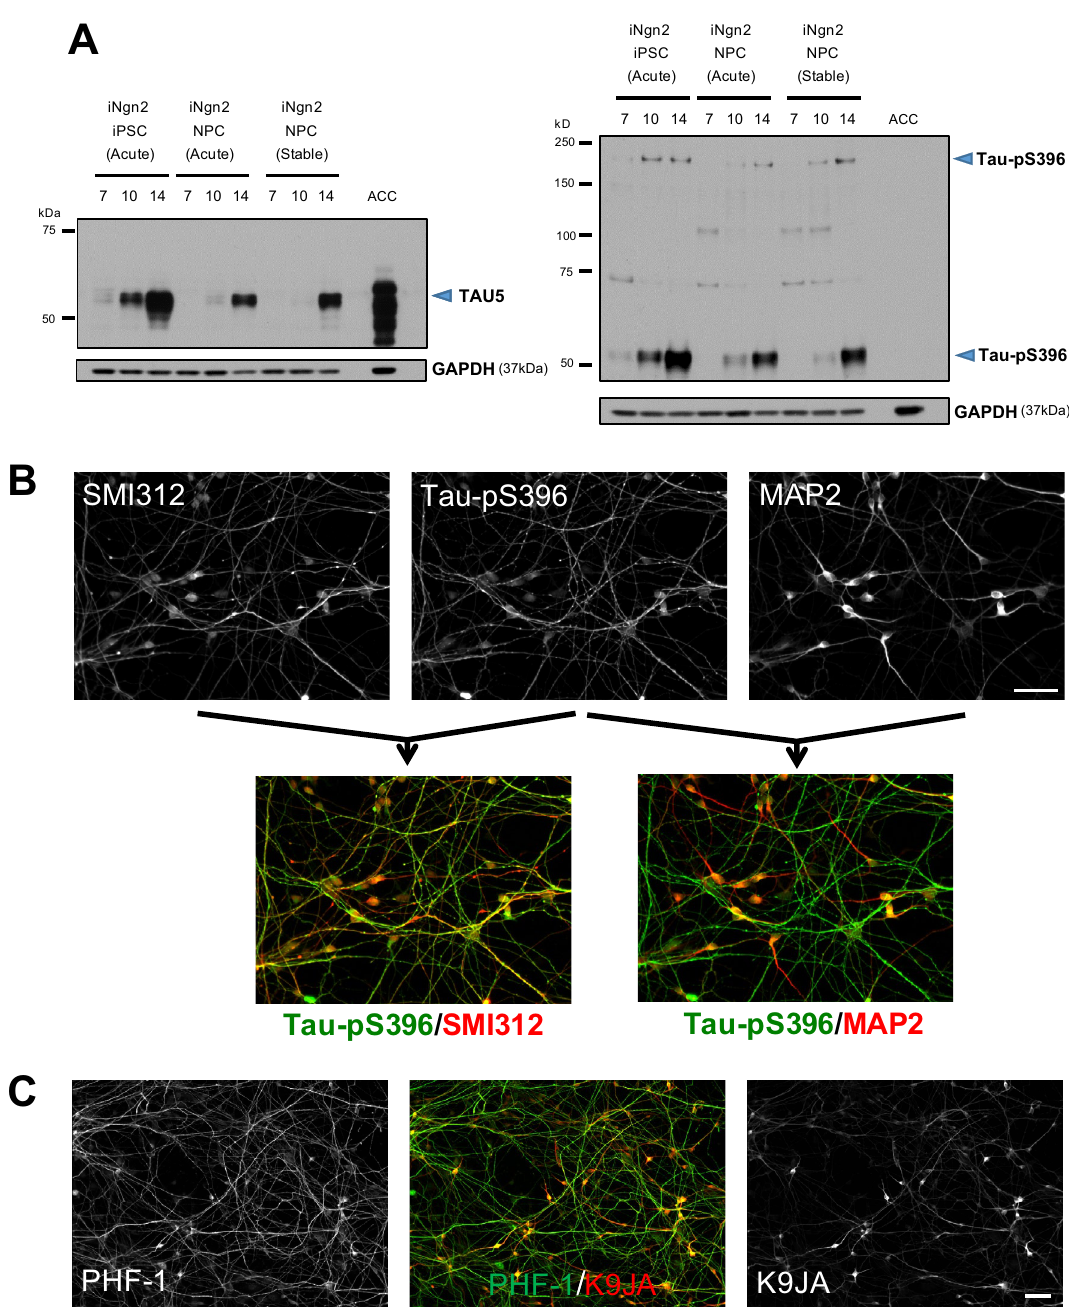
Figure 3. Protein expression and morphological characteristics of tau in iNgn2 neurons. (A) As assessed by western blots, there is robust expression of total tau (TAU5) and p-Tau (Tau-pS396) proteins in 14-day iNgn2 neurons from acutely transduced iPSC and NPC, and the iNgn2-NPC stable cell line. For comparison, human brain tissue from the anterior cingulate cortex (ACC) was also probed for tau expression. p-Tau was not detected in the ACC sample. This could be due to either enhanced tau phosphorylation in our iNgn2 neurons, or artifactual dephosphorylation that occurred during processing of the autopsied brain 38 . Full-length blots are presented in Supplementary Fig. S11. ( C ) Morphologically assessed by immunofluorescence imaging, p-Tau (Tau-pS396) preferentially colocalizes with the axonal marker (SMI312) and not the dendritic marker (MAP2) in 14-day iNgn2 neurons. Scale bar represents 50 μm. ( D ) Immunostaining of p-Tau (PHF-1) and total tau (K9JA) in 14-day iNgn2 neurons. Scale bar represents 50